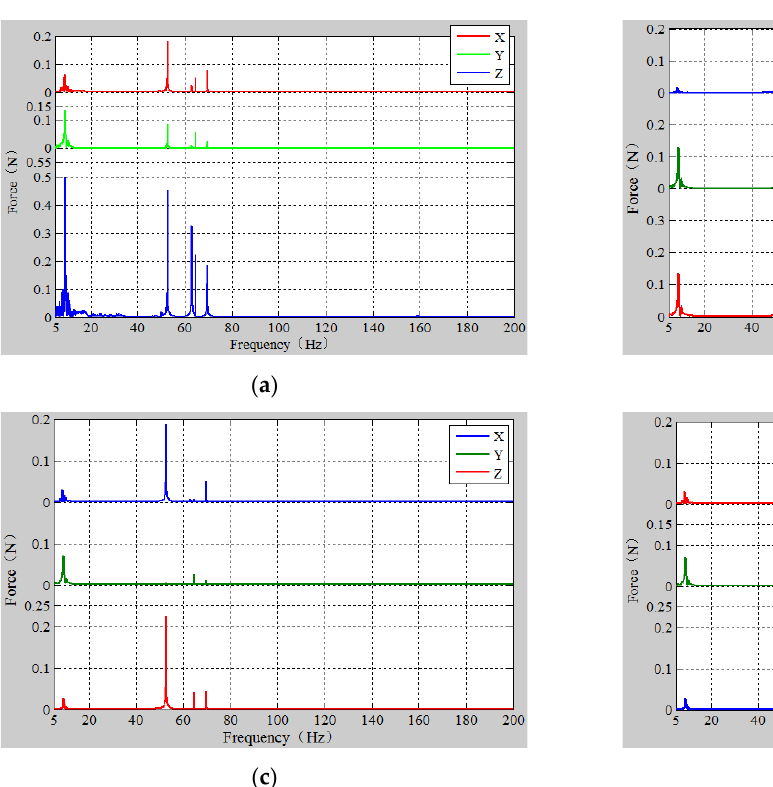
Figure 7. Analysis diagram of Z-direction path contribution of output point O3. As shown in Figure 6, the contribution of the Z-direction reaction force of O1 is ana- lyzed, and it can be seen that the excitation points 1X, 1Y, 2X, and 2Y contribute more to the reaction force, but the contributions of the excitation points 2X and 2Y are both nega- tive values, which can counteract the reaction force, so the paths I1:+X_O1:+Z and I1:+Y_O1:+Z are determined as the main reaction force transfer path. As shown in Figure 7, the contribution of the Z-direction reaction force of the out- put point 3 is analyzed, and it can be seen that the contribution of the excitation point 4Z is the largest, and the contribution of the remaining paths is small. The decision path I4:+Z_O3:+Z is the main reaction force transfer path. For the above three transfer paths, the transfer function of the full frequency range is shown in the following Figure 8.